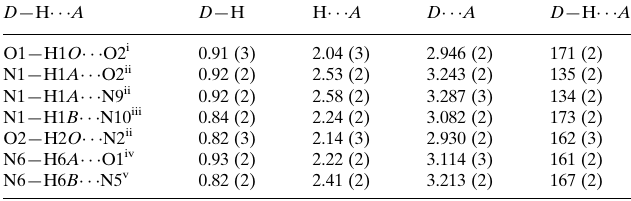
Hydrogen-bond geometry (A˚ , (cid:3)